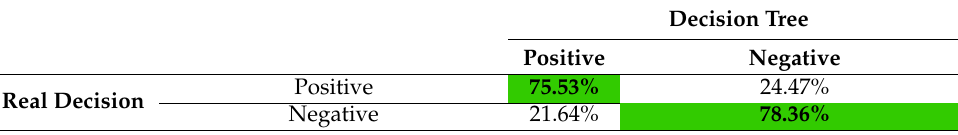
Table 1. Confusion matrix for decision